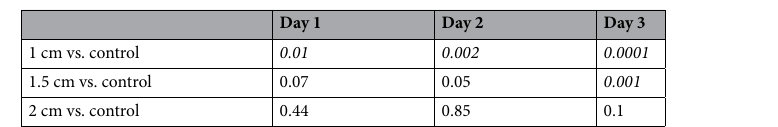
Table 1. Expansion rates comparison between control and various distances of CHX— p -values. Significant values are in